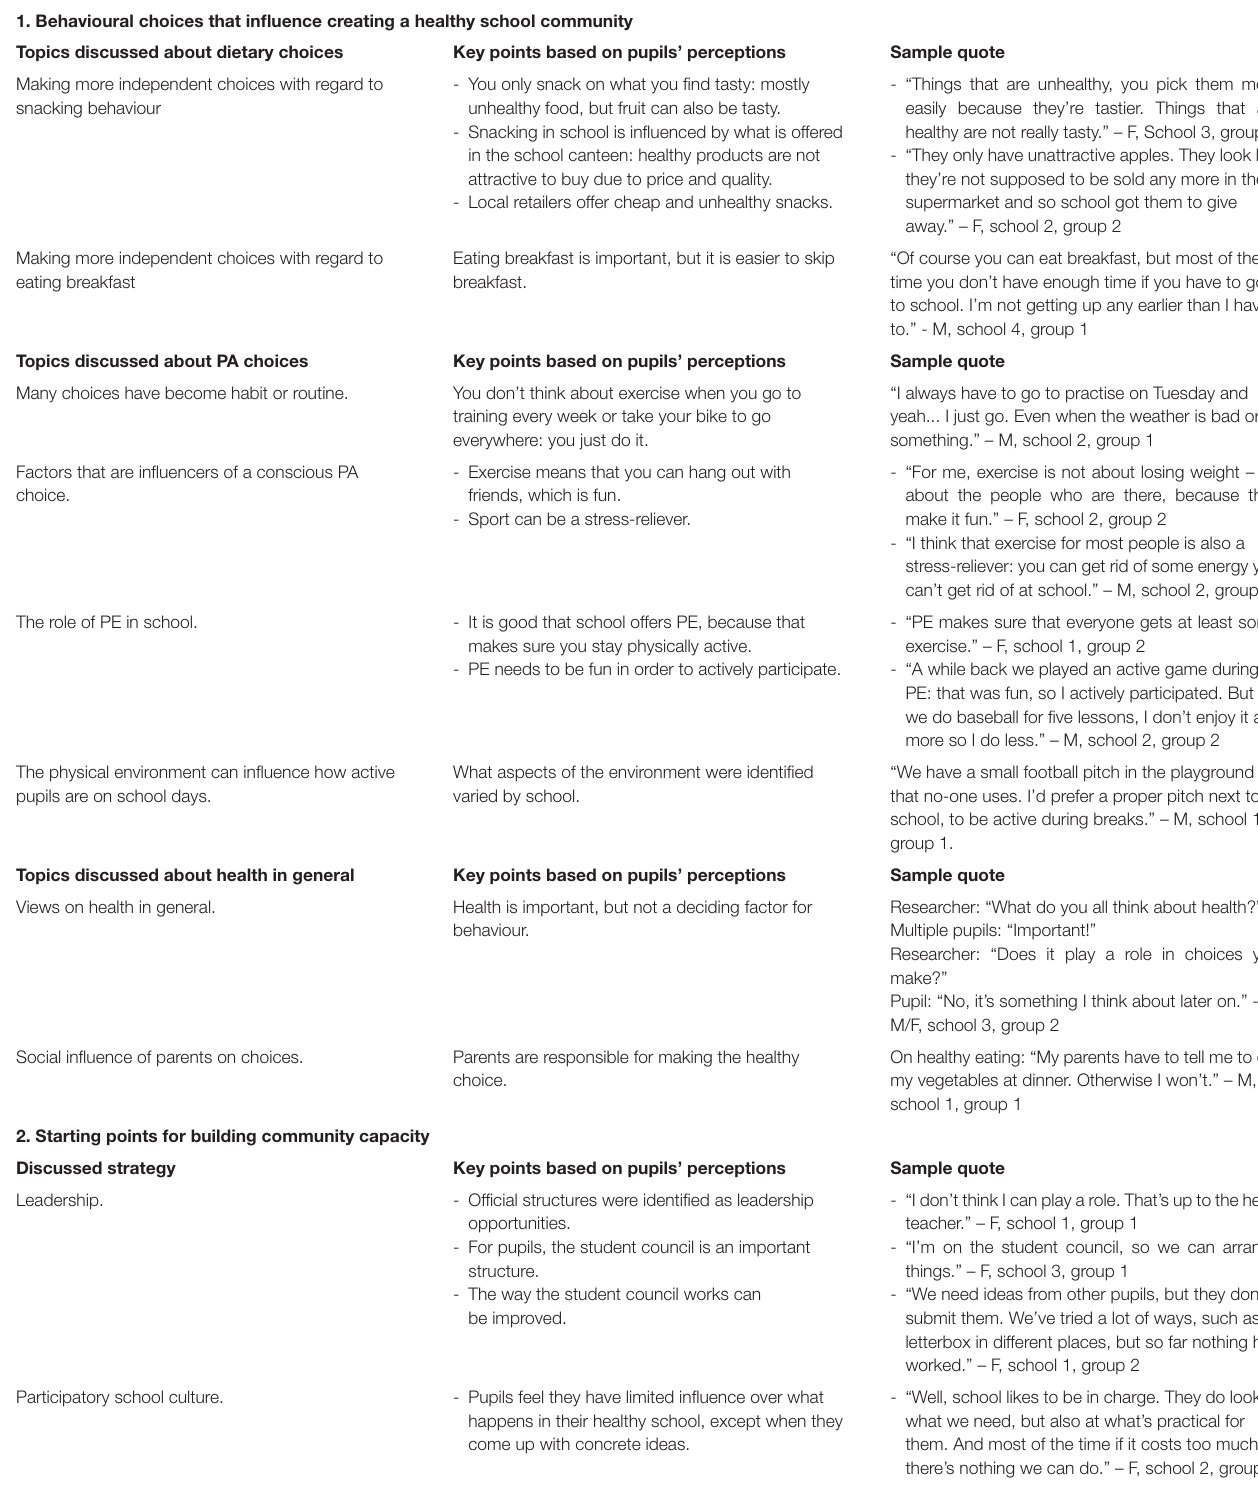
TABLE 3 | Overview of topics discussed and key points based on pupils’